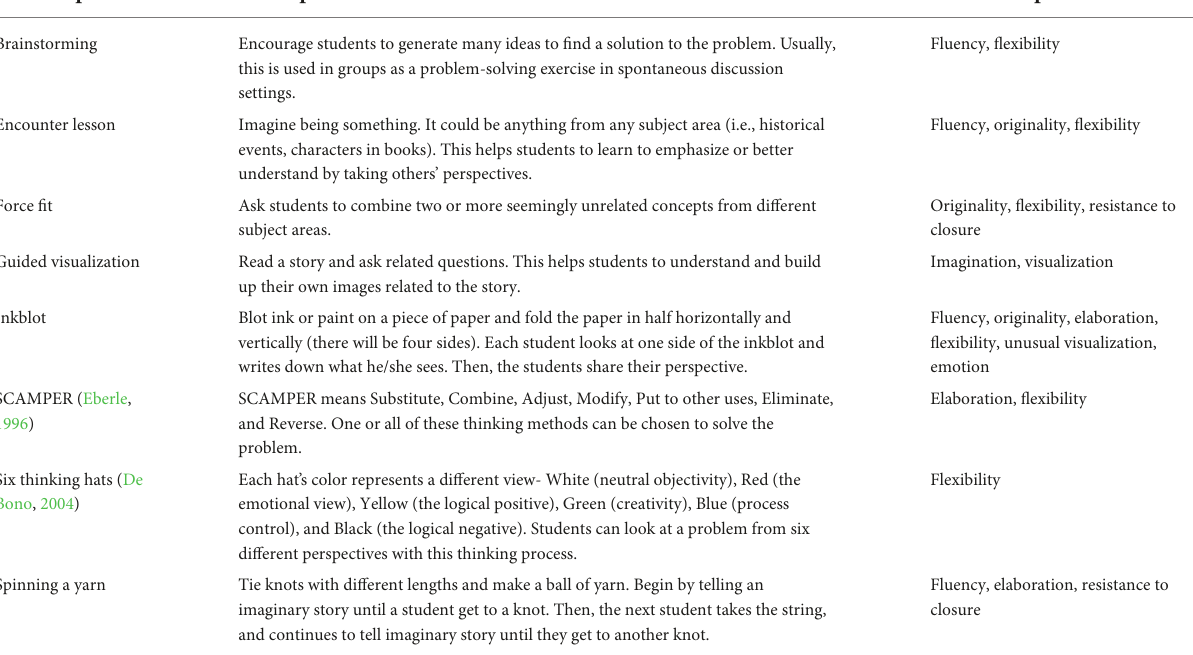
TABLE 2 Torrance Tests of Creative Thinking (TTCT) components and corresponding warm-up examples.